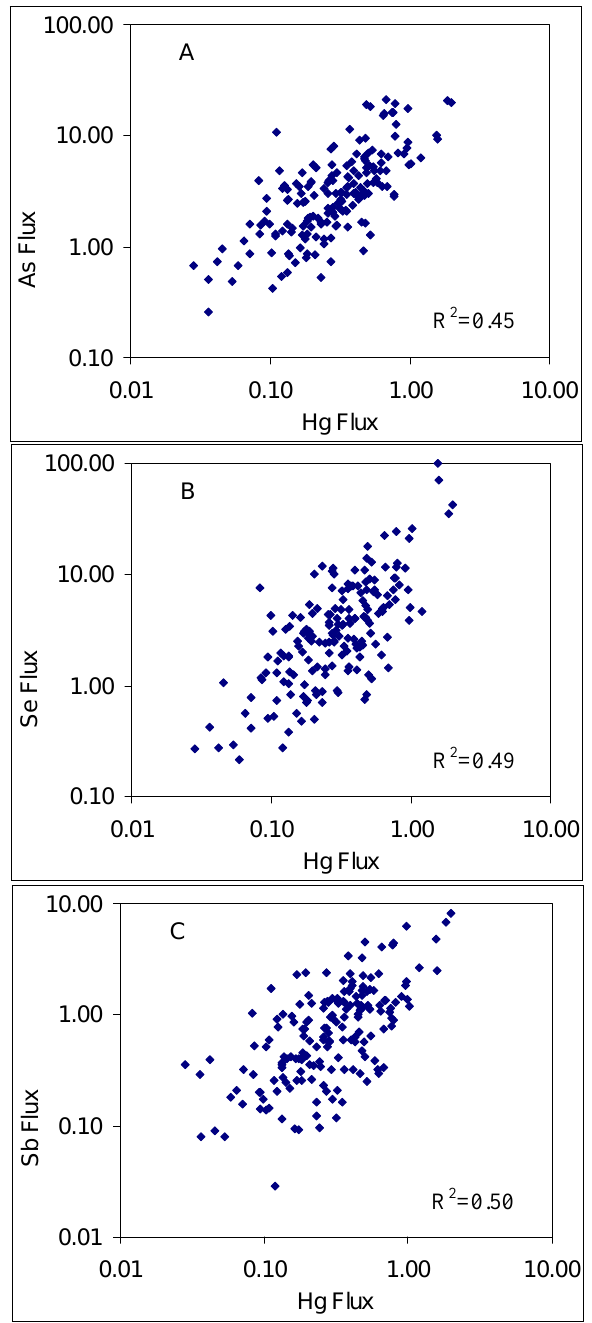
Fig. 6. Scatter plots of the rainfall flux data for As vs. Hg (A) , Se vs. Hg (B) , and Sb vs. Hg (C) . Correlation coefficients ( R 2 ) are from linear regression analysis. All flux units are µg/m 2 per rain event. Log axes are used to display the full range of the